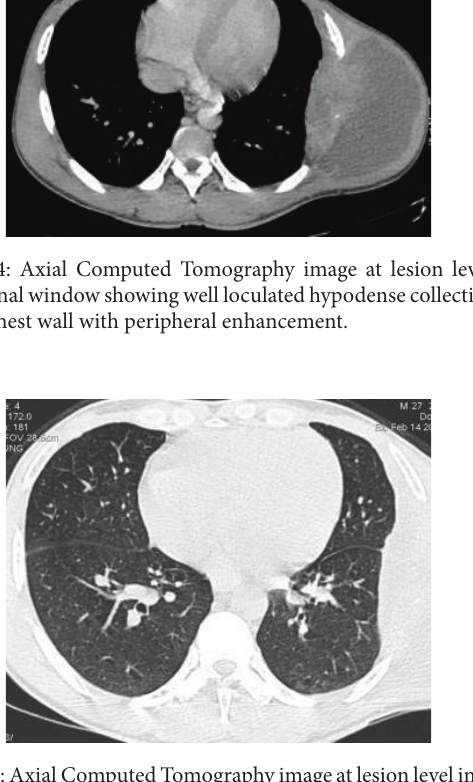
Figure 5: Axial Computed Tomography image at lesion level in lung window showing no evidence of lung parenchymal lesion.